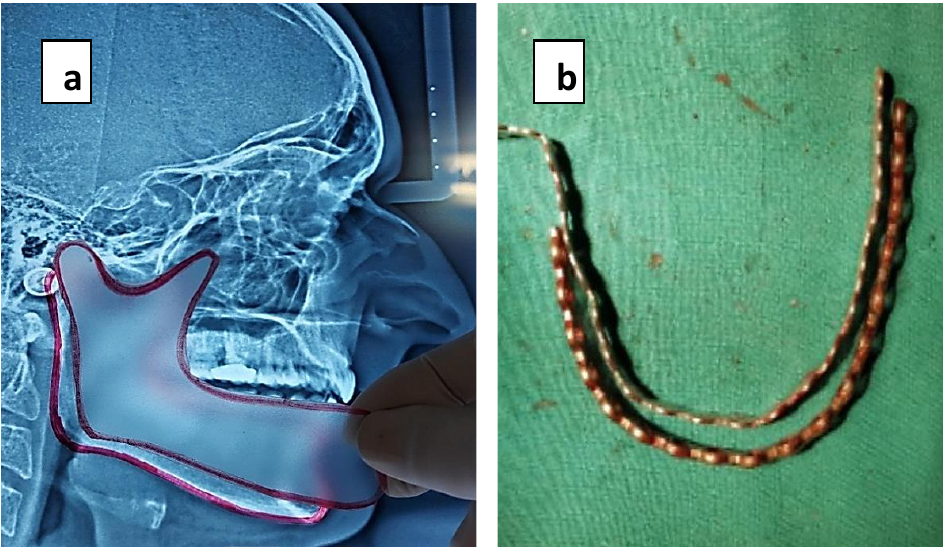
Figure 1. ( a , b ) Use of templates to shape the fibula into a new mandible. The second team was simultaneously involved in harvesting the flap. For pedicle orientation, whether anteriorly or posteriorly positioned, ipsilateral/contralateral limbs were selected as the donor tissue for fibula flap harvest. Evaluation and examination of the lateral limb were performed with a hand-held Doppler exact identification and the skin marking of the perforating vessels in the septum. For osteocutaneous flap, the skin flap was planned in such a fashion that would incorporate at least one vessel. The selected limb was raised for 5 min at 45 ◦ before tourniquet inflation using an Esmarch’s bandage for surgical hemostasis to facilitate draining of the blood vessels from the distal end to the proximal end, creating a clear surgical field with total blood loss reduction and decreasing post-tourniquet-release risk of microemboli formation. Tourniquet application was performed strictly according to Bruner’s ten rules for the safe use of tourniquet (modified by Braithwaite and Klenerman)